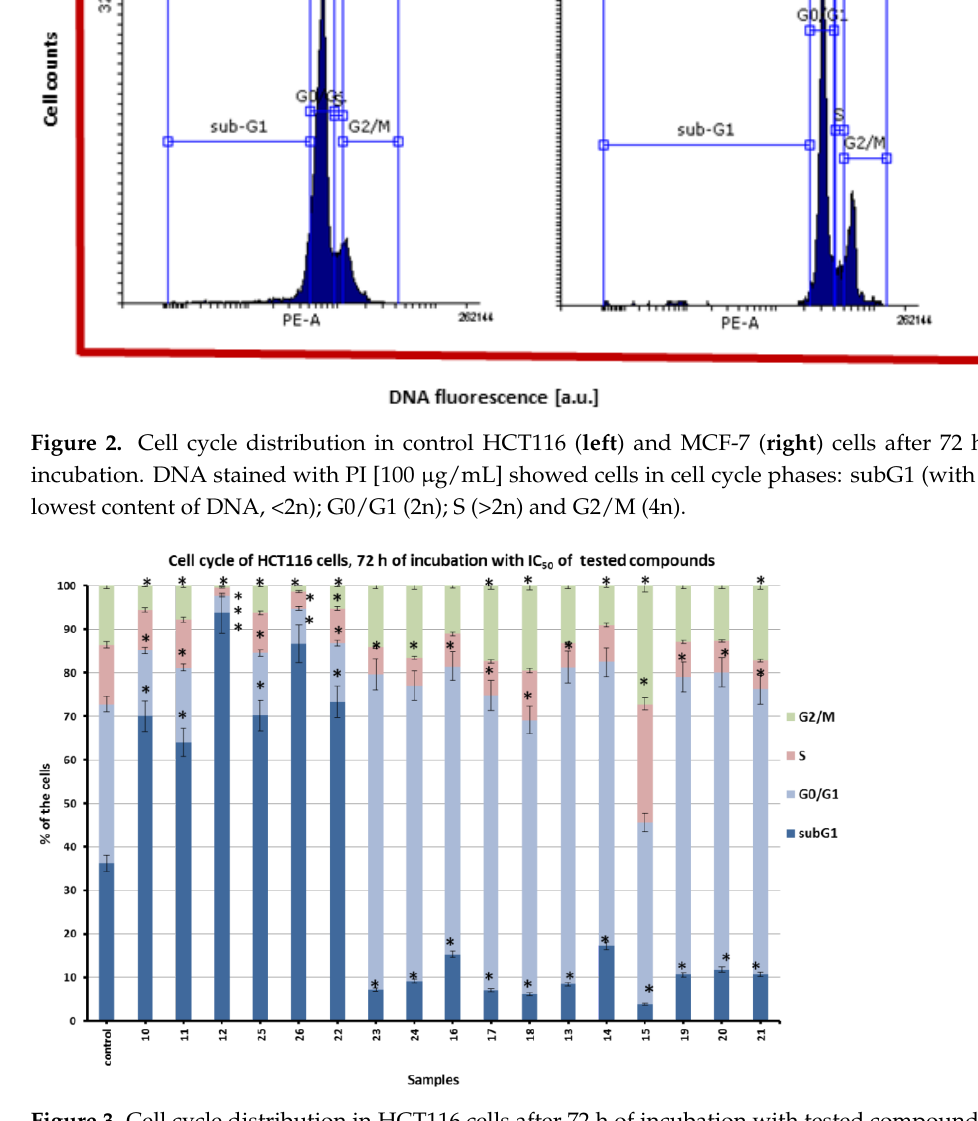
Figure 4. Cell cycle distribution in MCF-7 cells after 72 h of incubation with tested compounds at IC 50 dose or 100 μM for no effective compounds, based on Table 2. The subG1 fraction represents apoptotic and dead cells. Results presented as mean of 3 experiments ± SD. Statistical significance indicated by star; evaluated by T-test, where p < 0.05. In contrast, for the HCT116 cell line, a slight increase in cell number was observed in the G0/G1 phase for compounds 13 , 14 , 16 , 17 , 18 , 19 , 20 , 21 , 23 and 24 , which may appear on a cell cycle blockade, probably because of the disruption of cell cycle checkpoints (Fig- ure 3). Upon further analysis of the tested compounds, no cell growth was observed in the phases G0/G1 and S, with the exception of the 15 treatment for the HCT116 cells, where it significantly affected S-phase elevation compared to the untreated control (Figure 3). Based on the results obtained on the cell cycle distribution in MCF-7 cells, after 72 h of treatment, a visible increase in apoptotic cells was observed in the subG1 fraction,